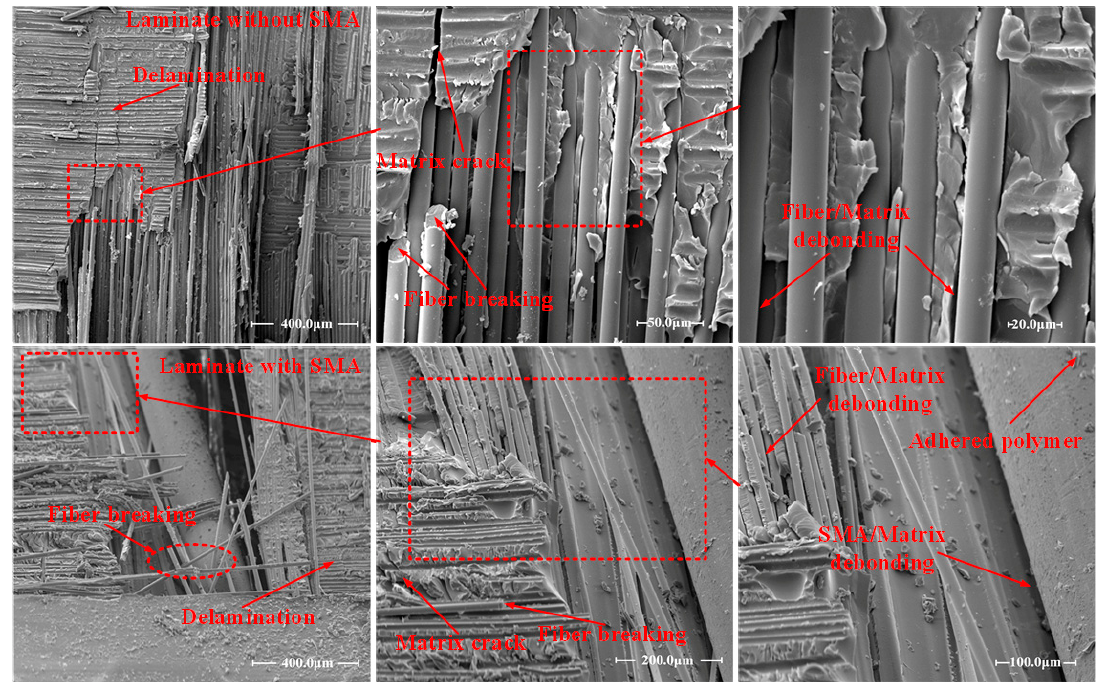
Figure 8. Typical SEM images obtained on the face-sheets.